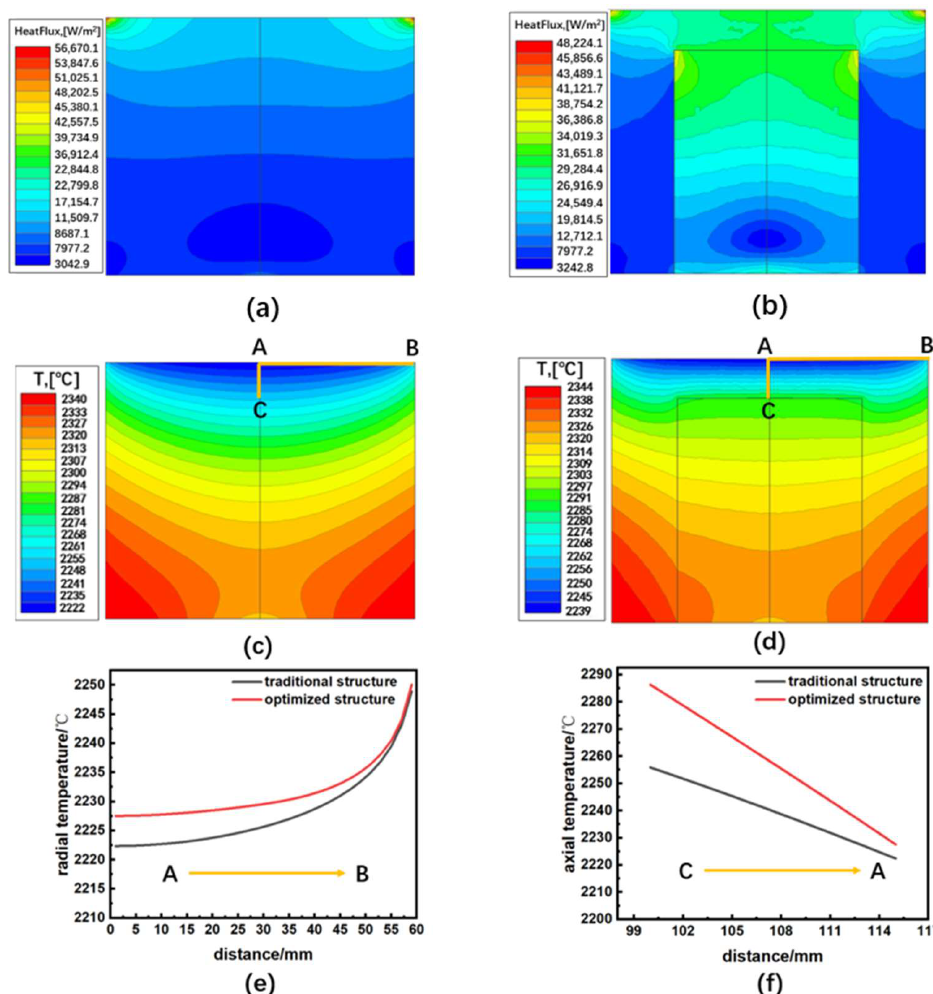
Figure 3. The thermal field in the SiC powder: ( a ) the heat flux in the traditional structure, ( b ) the heat flux in the optimized structure, ( c ) the temperature distribution in the traditional structure, ( d ) the temperature distribution in the optimized structure, ( e ) the radial temperature gradient, and ( f ) the axial temperature gradient.